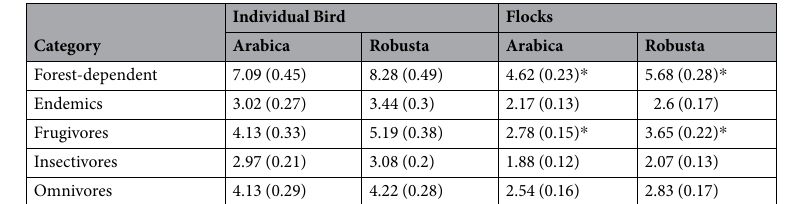
Individual Bird Flocks Arabica